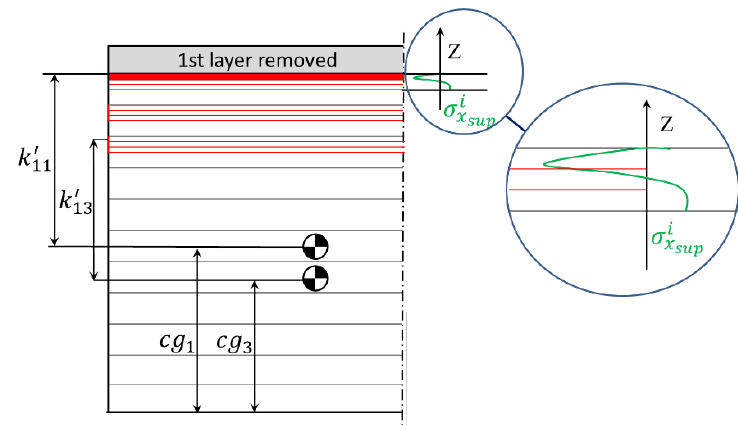
Figure 4. Machining-induced residual stresses (MIRS) on the surface, sublayers after machining the three first layers, and distances to the neutral plane of each of the affected layers.